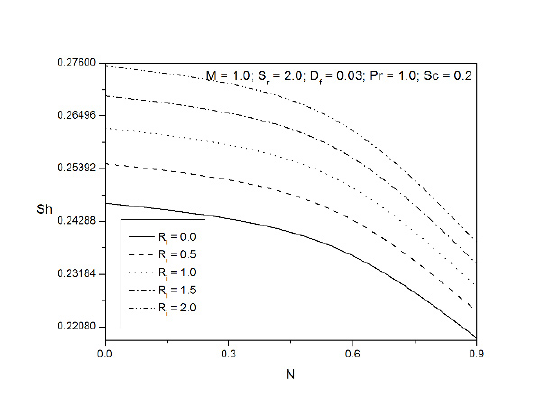
i on Mass Transfer